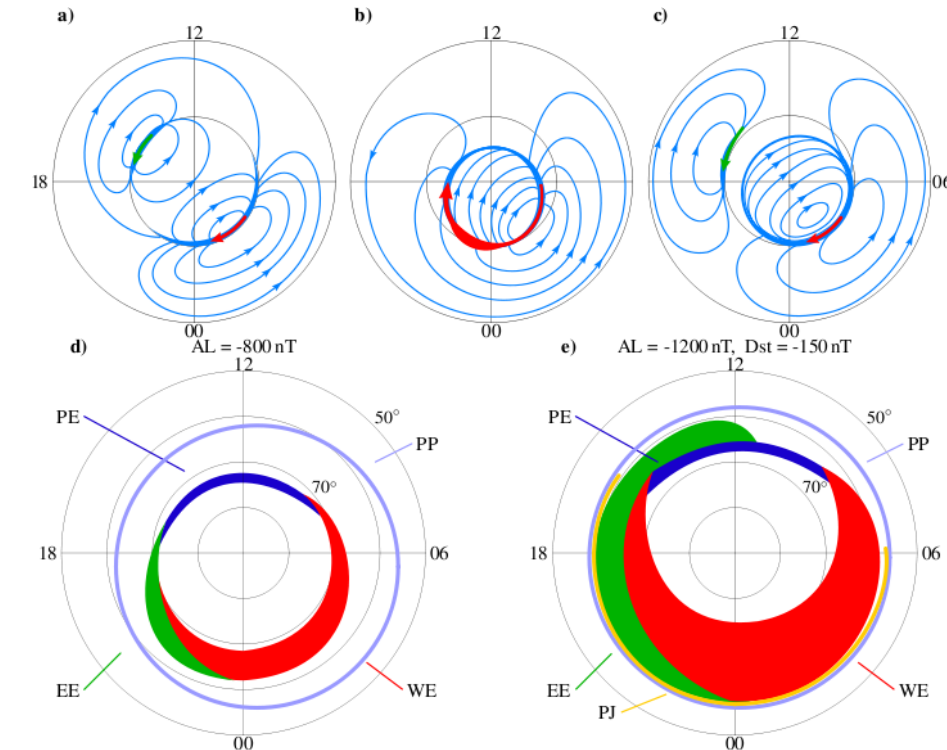
Figure 10. Schematic view of the electrojet’s space-time distribution at ionospheric altitudes: (a) classical current system according to Fukushima (1953); (b) single-vortex system with westward electrojet along the auroral oval according to Akasofu et al. (1965); (c) double- vortex system with westward electrojet along the auroral oval and eastward electrojet in the evening sector at latitudes of the auroral zone according to Feldstein and Zaitsev 1965b); (d) the magnetospheric substorm with AL ∼ − 800nT; (e) the magnetic storm main phase with AL ∼− 1200nT, Dst ∼− 150nT ( d and e by Feldstein et al.,